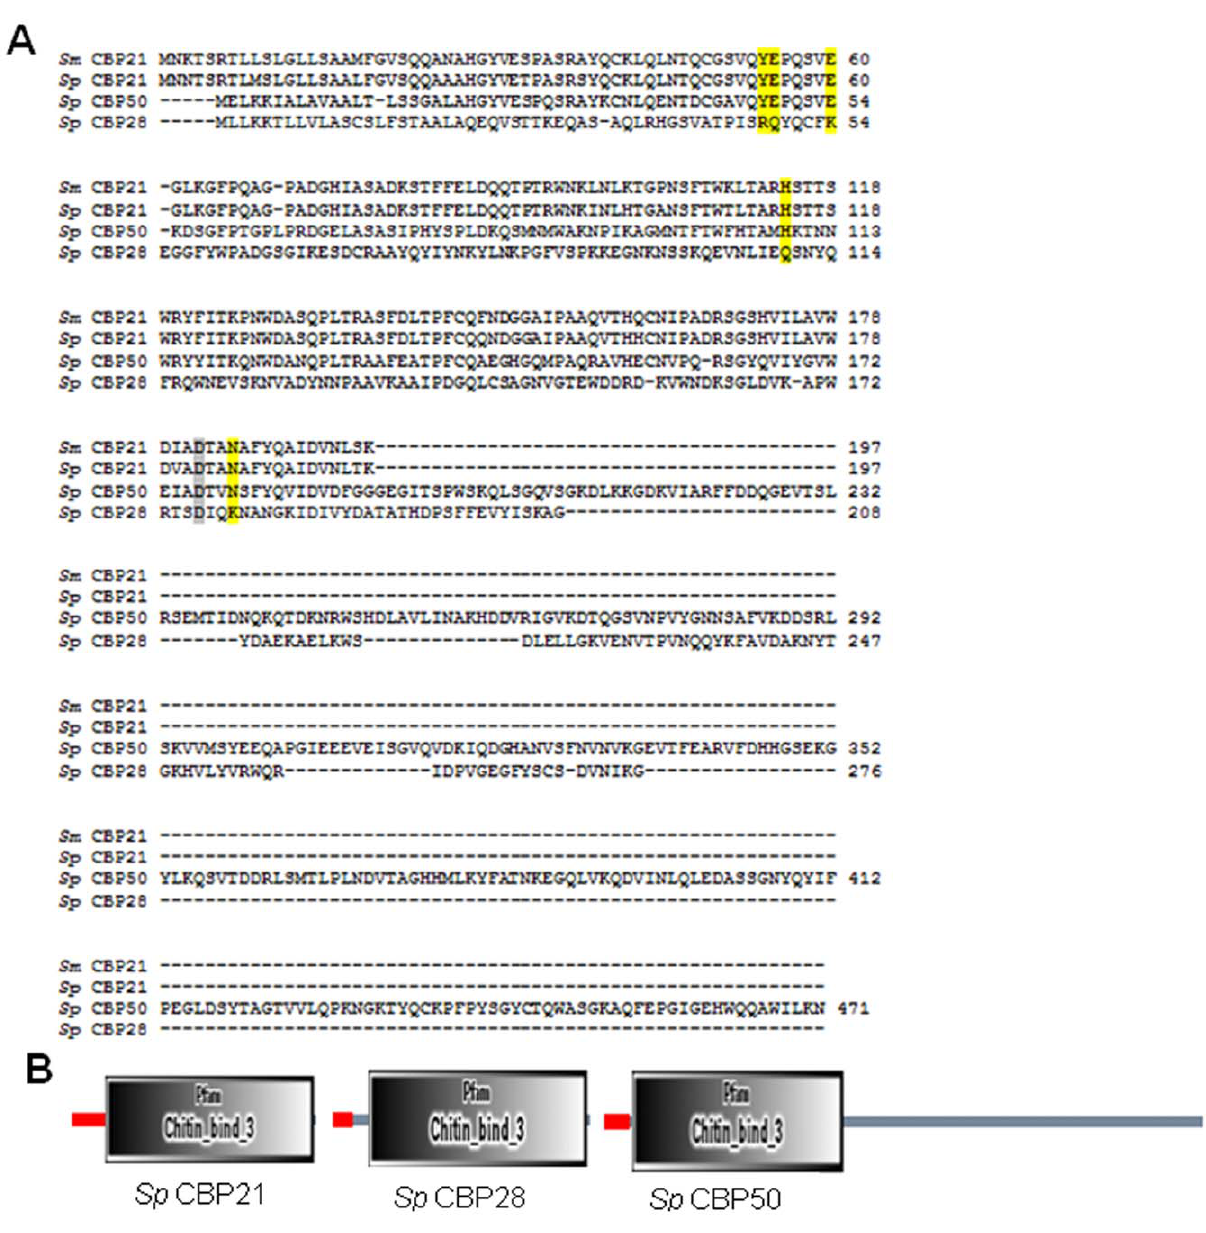
Figure 3. Sequence alignment and domain organisation for Sp CBPs. (A) Full-length sequences of Sp CBP21, Sp CBP28, Sp CBP50 and Sm CBP21 (CBP21 from S. marcescens ) were aligned using clustalw2. Residues that are thought to be located in the binding surface for chitin present in Sm CBP21, Sp CBP21, Sp CBP50 and not present in Sp CBP28 are shaded in yellow (as derived from the crystal structure of Sm CBP21, as well as mutagenesis studies [7,8]). Residue involved in the chitin-binding and functional properties of Sm CBP21 but also conserved in Sp CBP28 are shaded grey. The arrow indicates the terminal amino acid of the N-terminal signal sequence for respective CBPs. (B) The sequences of Sp CBPs were submitted to SMART domain data base (http://smart.embl-heidelberg.de/). The part indicated in red colour shows the signal peptide and the region Chitin_bind_3 indicates the chitin binding domain.